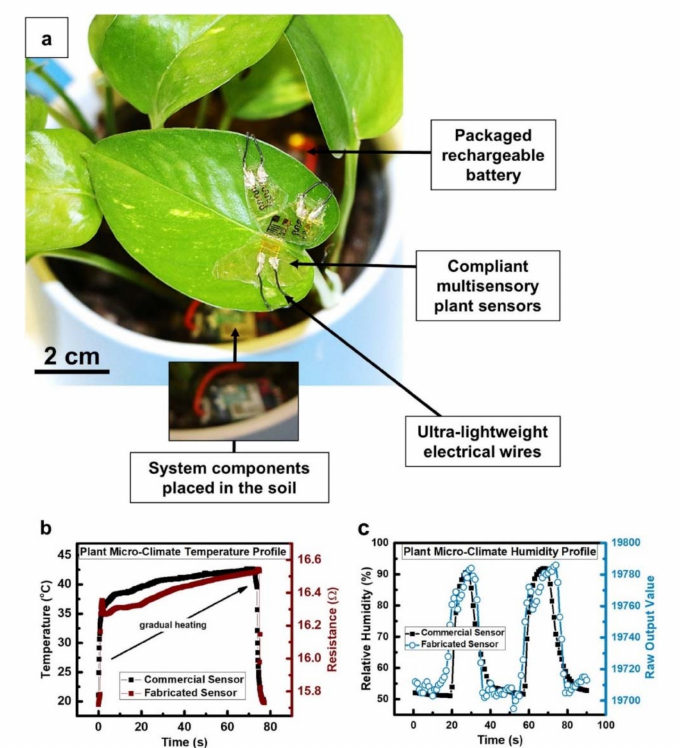
Figure 7. ( a ) Wearable sensors for real-time microclimate monitoring of temperature and humidity levels; ( b ) comparison between real-time response of fabricated and commercial temperature sensors, concerning temperature profile around the plant.; ( c ) real-time plot of fabricated humidity sensor in comparison to a commercial sensor’s behavior, concerning humidity levels around the plant (reproduced from [107], licensed under the Creative Commons